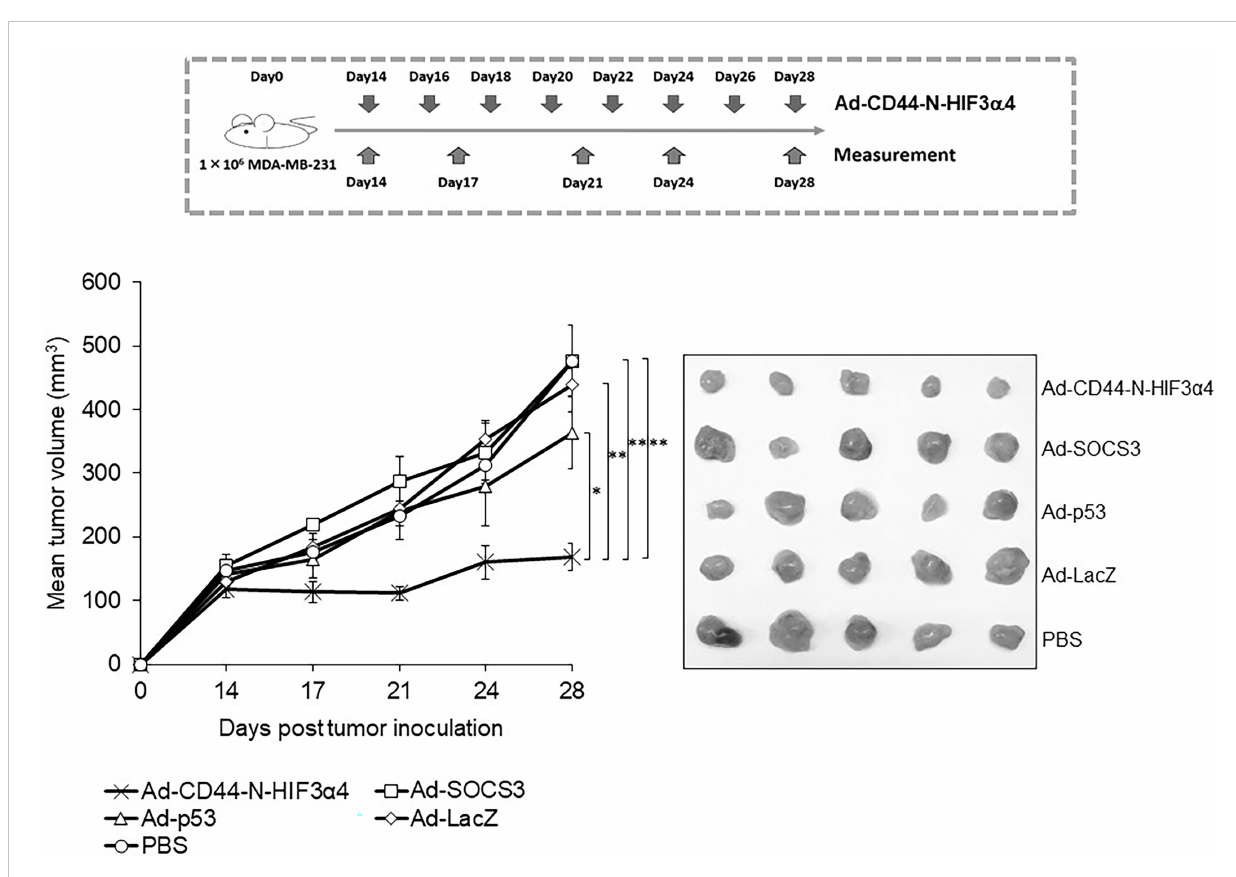
FIGURE 9 Anti-tumor effect of Ad-CD44-N-HIF3 a 4 in mice with MDA-MB-231 tumors One million MDA-MB-231 cells were subcutaneously inoculated into nude mice and intratumoral injections of Ad-CD44-N-HIF3 a 4, Ad-SOCS3, Ad-p53, Ad-LacZ or PBS were performed every other day for 8 times. Ad- CD44-N-HIF3 a 4 signi fi cantly inhibited the growth of MDA-MB-231 tumors compared to Ad-p53 (p< 0.05), Ad-SOCS3, Ad-LacZ and PBS (p< 0.01). (n=5, average ± SE bars, *p< 0.05, **p<